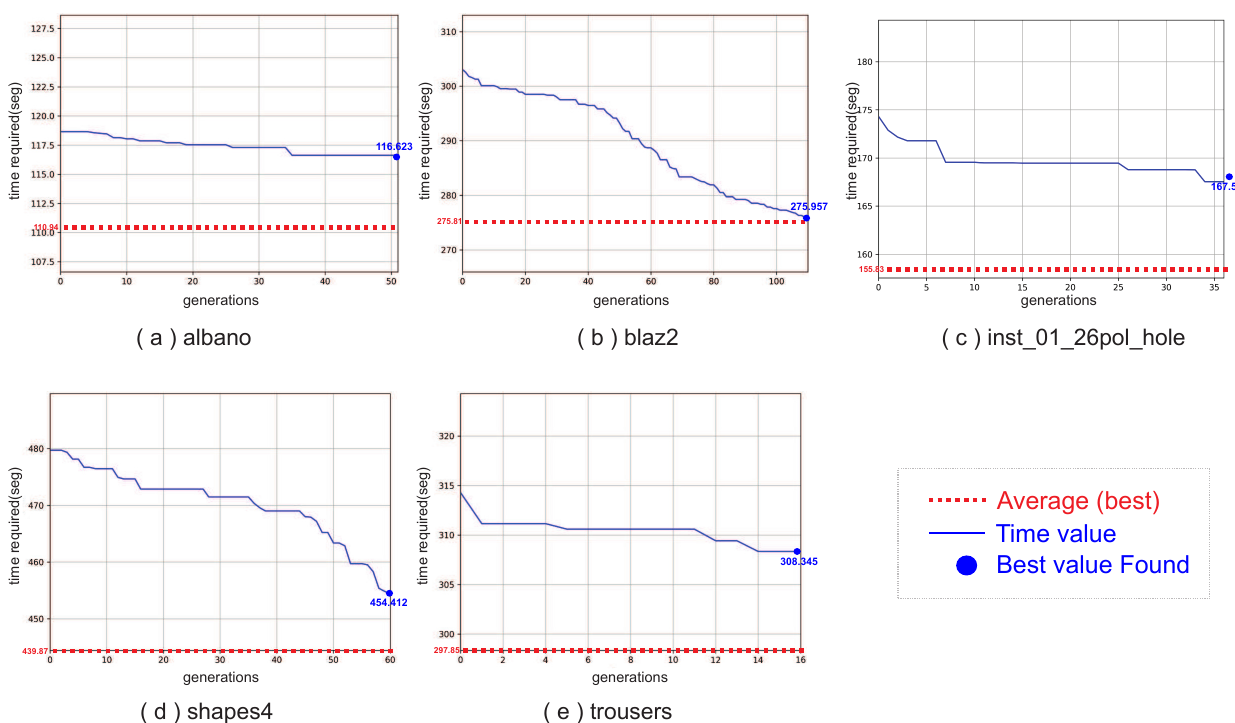
Figure 14. Evolution process defined for time limit reached instances in C-group. Configuration of BRKGA: [ P = 10,000, P e = 0.20, and P m =